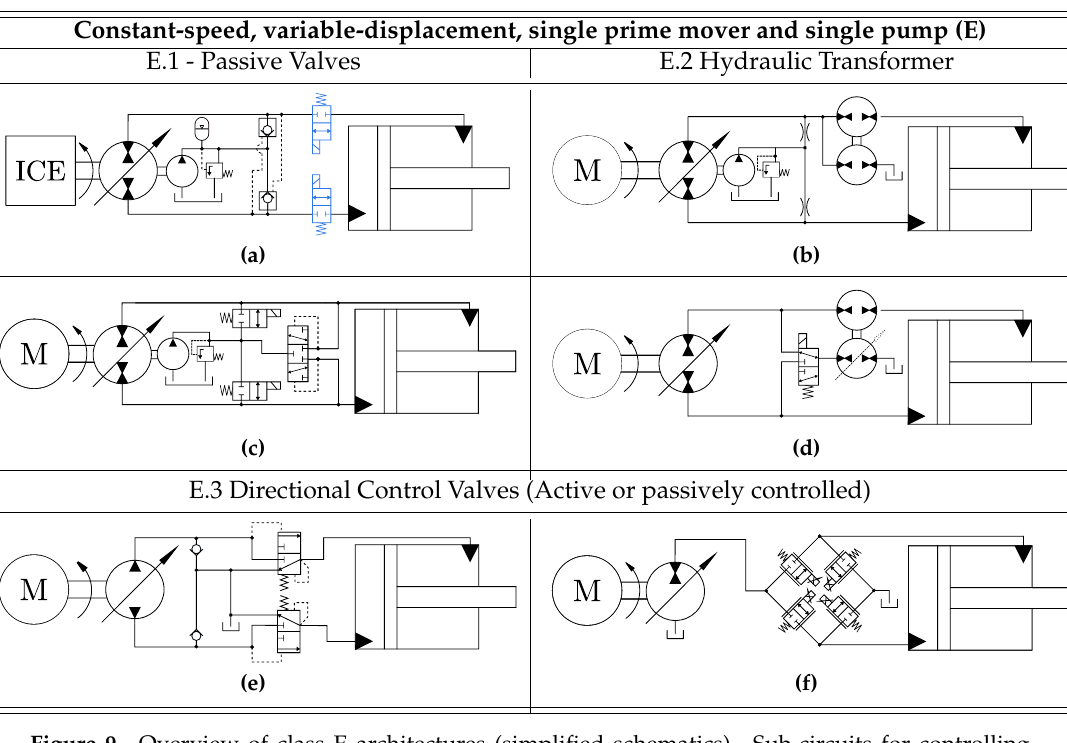
Figure 9. Overview of class E architectures (simplified schematics). Sub-circuits for controlling the displacement of the main pump is not showed in all schematics. ( a ) Architecture based on pilot-operated check valves; ( b ) Architecture based on hydraulic transformer; ( c ) Architecture based on inverse shuttle valve; ( d ) Architecture based on variable hydraulic transformer; ( e ) Architecture based on passively actuated directional valves; ( f ) Open-circuit architecture based on actively controlled proportional